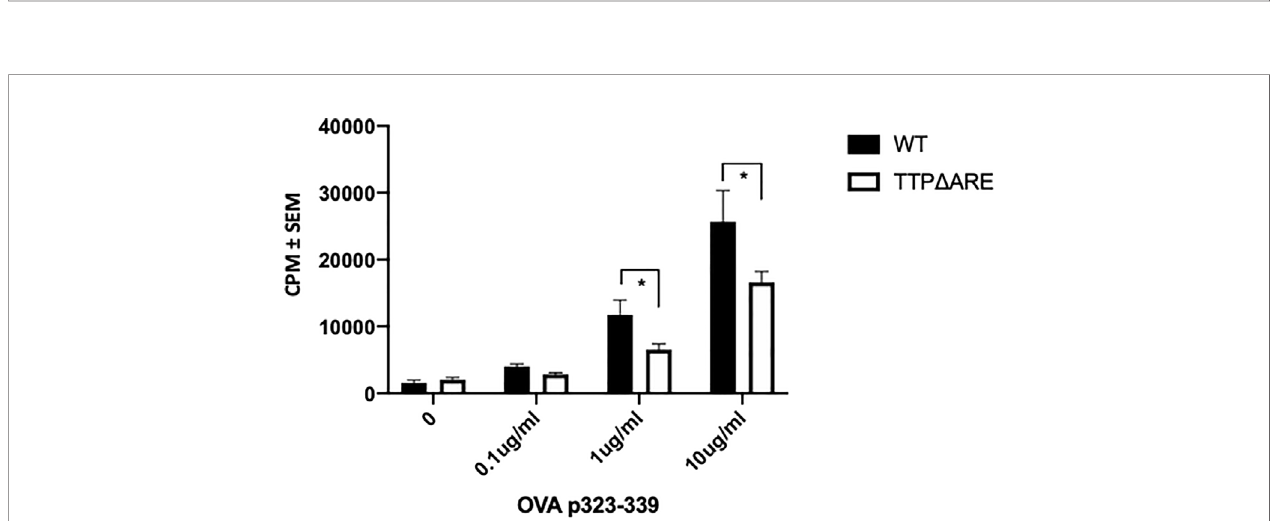
FIGURE 8 | TTP D ARE mice are de fi cient in their antigen presentation ability. Naïve CD4 + T cells from OTII mice were cultured with irradiated splenocytes from TTP D ARE mice, or WT controls, in the presence of OVA323-339 peptide for 48 h. The responses were determined by the incorporation of tritiated thymidine. t-test was used for statistical comparisons, *p < 0.05. Combined data of two